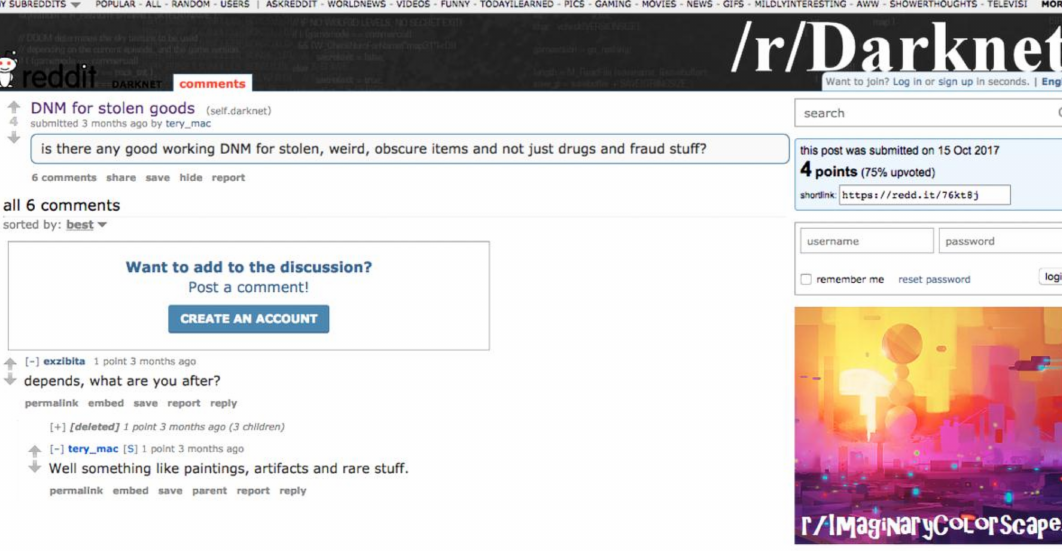
Figure 9. Screen grab of the subreddit for Darknet (r/Darknet) with a request for stolen goods and a conversation to specify artifacts and rare items. (Screen grab by author